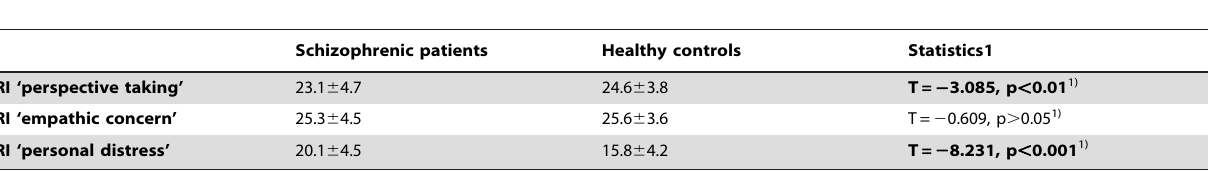
Table 2. Self rated dimensions of empathy (Interpersonal Reactivity Index, IRI) in schizophrenic patients (n= 145) and controls (n=145); between-group comparisons.